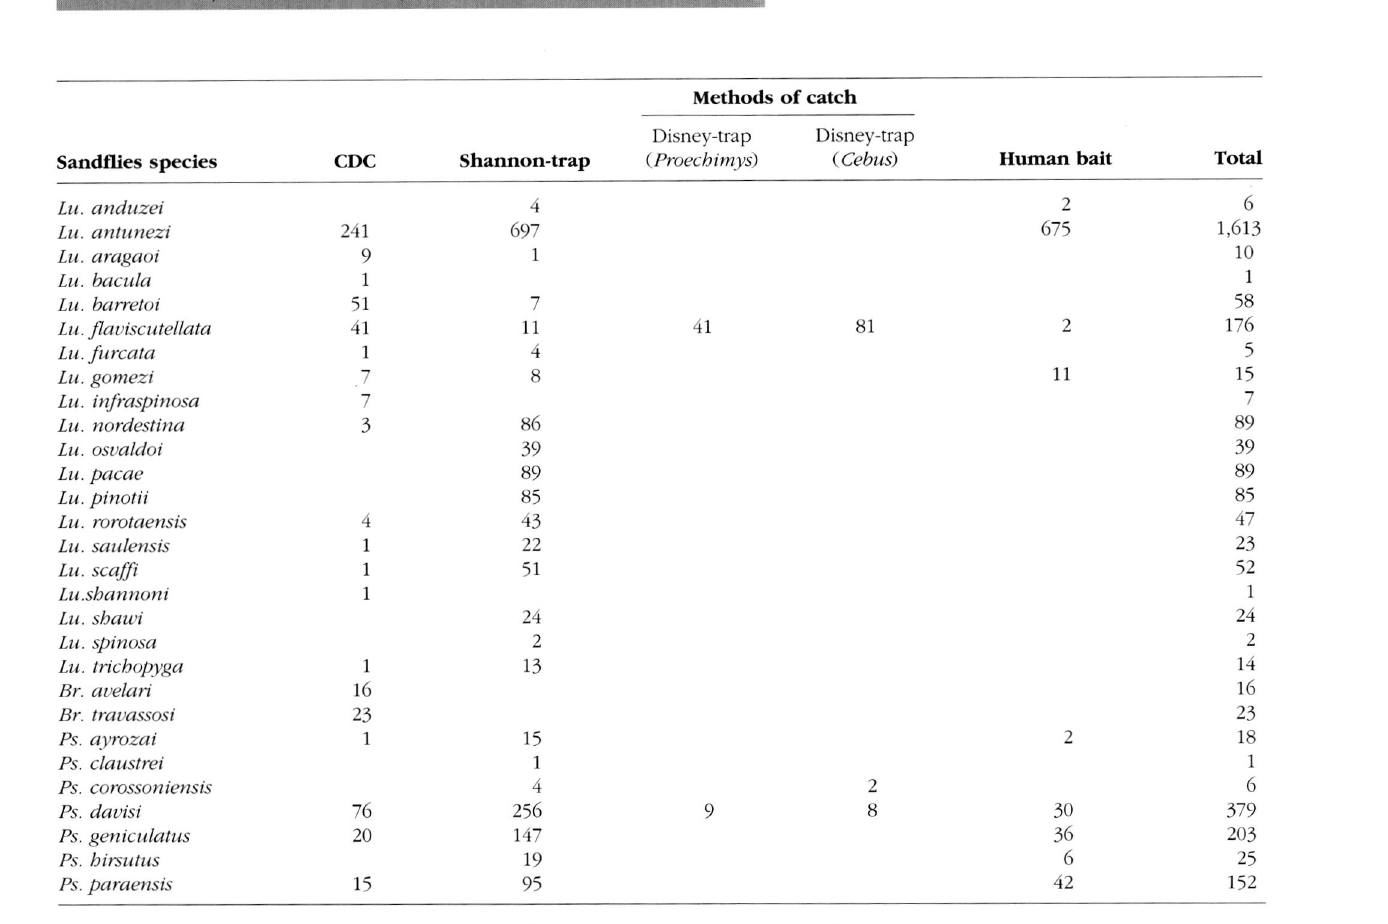
Table III. - Sandfly collections made in the area of 2 nd Batallion of the Forest Infantry (2° BIS), Belem, Para, Brazil, during the period bet­ ween October 30 lh 1996 to February 2 th 1998.